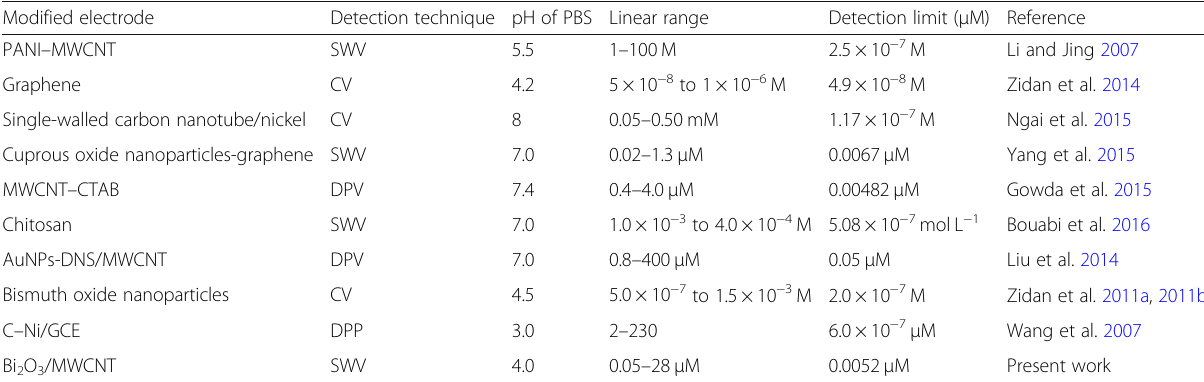
Table 2 Comparison of different chemically modified electrodes for the determination of paracetamol with the present fabricated sensor